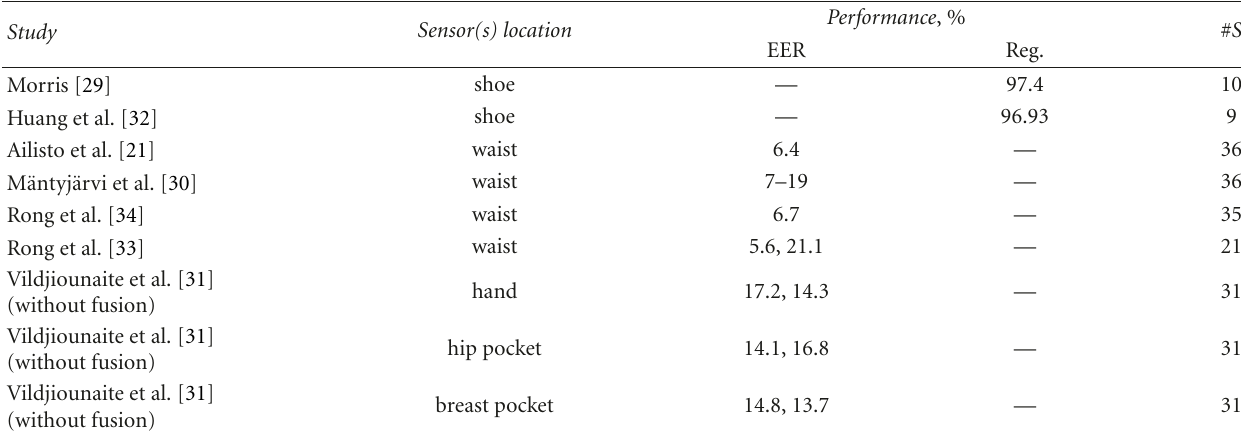
Table 3: Summary of the current WS-based gait